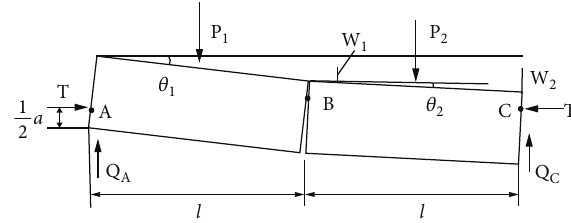
Figure 3: Simpli fi ed “ masonry beam ” model